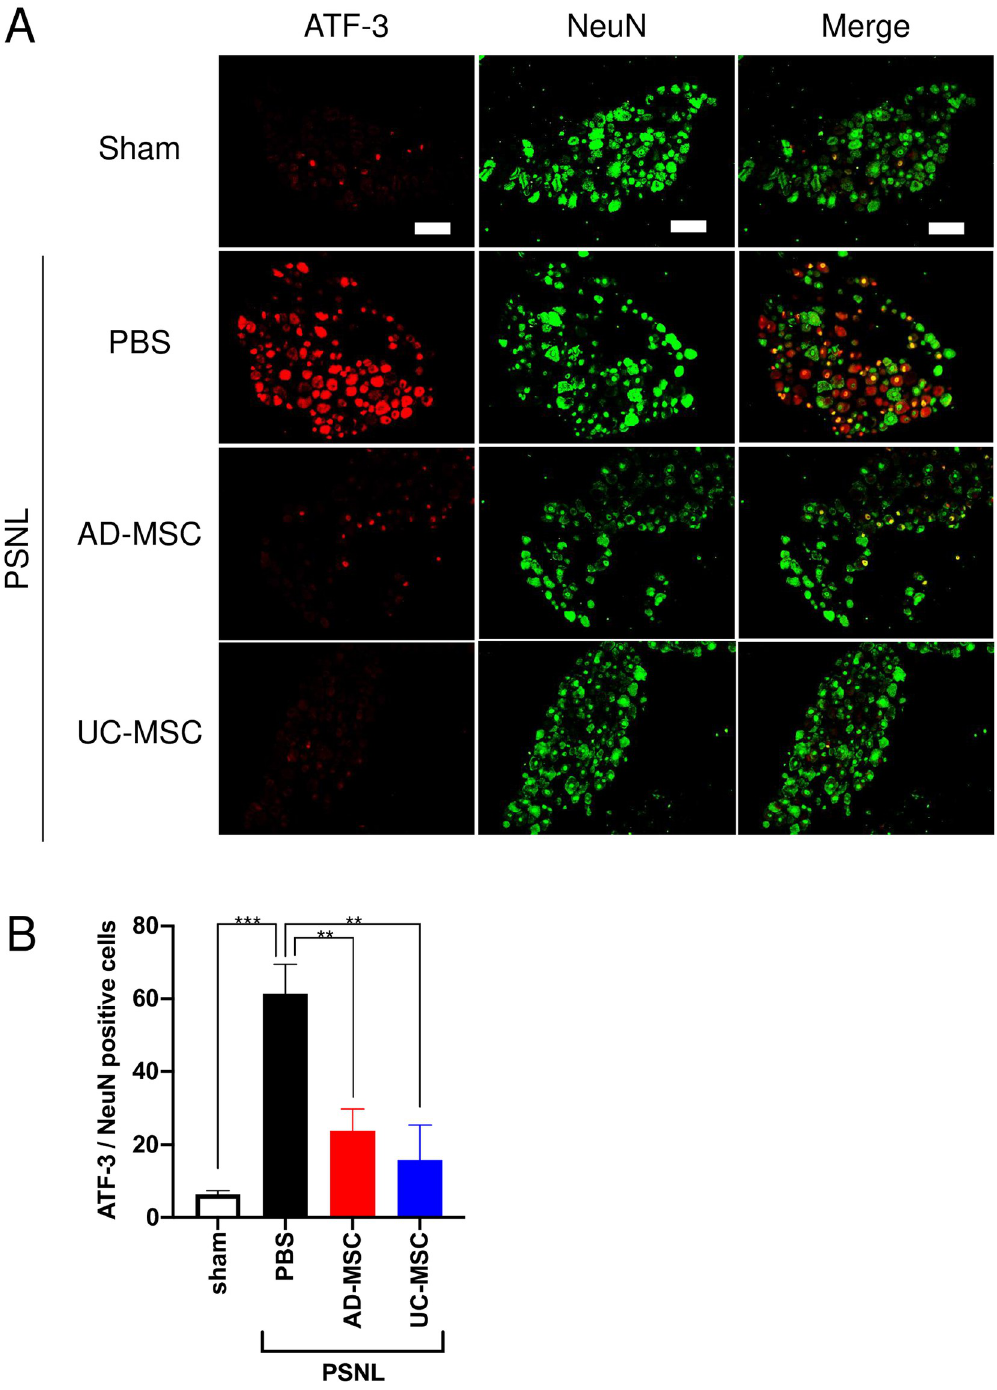
Fig 2. Changes in expression of ATF-3 and NeuN in the DRGs of PSNL-exposed rats and the effects of treatment with MSCs. On day 4 after partial sciatic nerve ligation (PSNL), AD-MSCs, UC-MSCs (5 × 10 6 cells/mL), or its vehicle (PBS) was administered intravenously. On day 3 after injections, DRG were dissected from rats. The protein expression of MBP and NF200 in the DRG was measured by immunohistochemical analysis (A). The data are expressed as mean ± standard error of the mean (B, sham; n = 5, PBS; n = 6, AD-MSC; n = 4, UC-MSC; n = 4). �� and ��� indicate p < 0.01 and p < 0.001, respectively: Bonferroni’s multiple comparison test was performed following a one-way analysis of variance. Scale bar = 100 μ